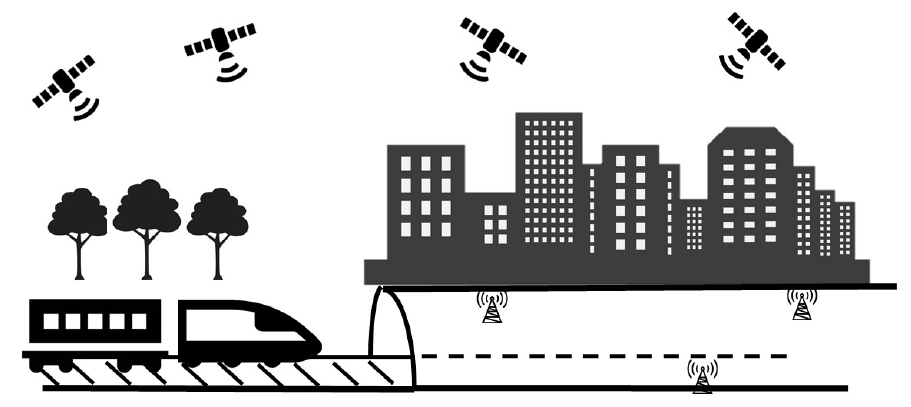
Figure 1. Use case of the UWB-aided GNSS in a tunnel [16].